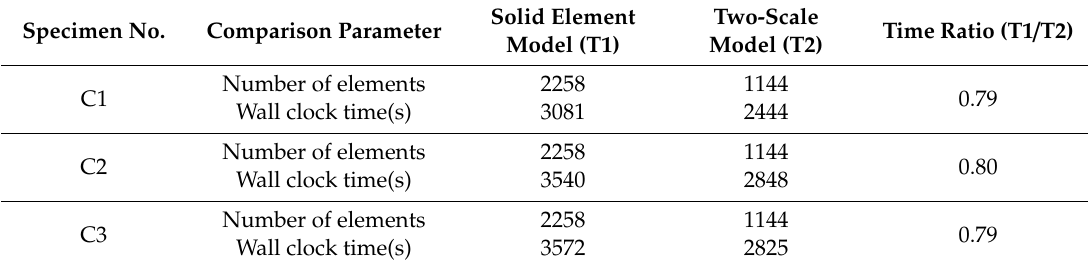
Table 4. Comparison of element numbers and computation time of XFEM-based numerical models. Specimen